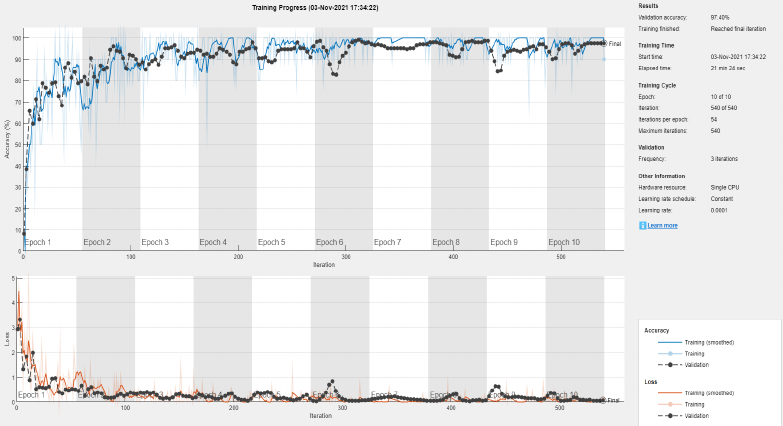
Figure 15. Figure showing training of AlexNet using Transfer learning on the Color recurrence plots combining the classes into a single classification